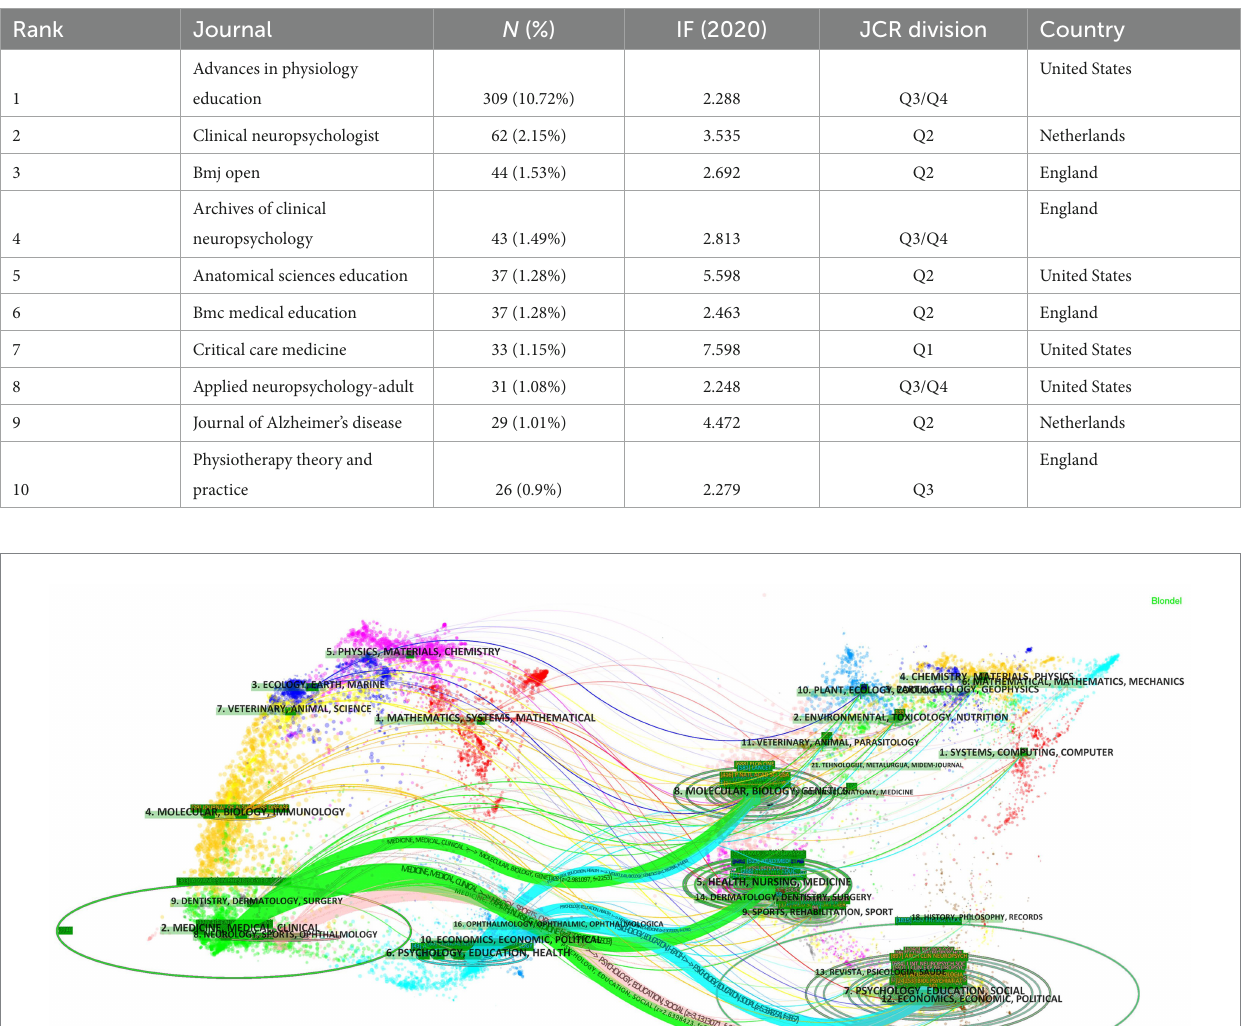
TABLE 5 The top 10 journals of physiology teaching reform research.